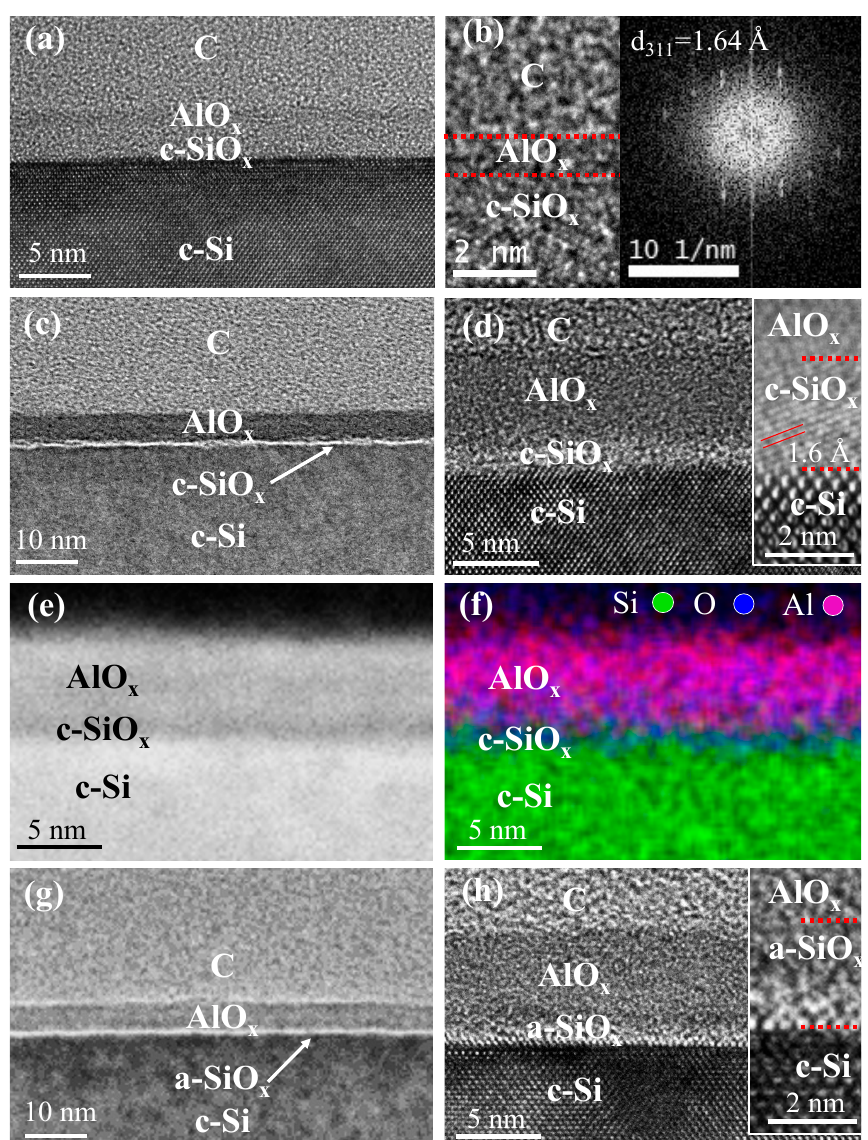
Figure 3. ( a ) HRTEM image of as-deposited 1.5 nm AlO x layer, with the enlarged view in ( b ). Inset showing the Fourier transform. ( c ) Low magnification TEM image of as-deposited 5 nm AlO x layer with HRTEM image shown in ( d ). ( e ) STEM-HAADF image of as-deposited 5 nm AlO x layer. ( f ) STEM-HAADF EDX mapping of as-deposited 5 nm AlO x layer. ( g ) Low magnification TEM image of 5 nm AlO x layer annealed in vacuum and the corresponding HRTEM image in ( h ). Insets of the figure ( b , d , h ) show the corresponding HRTEM images, evidencing the crystalline/amorphous character of different layers. Red dashed lines are provided as a guide to the eye for different